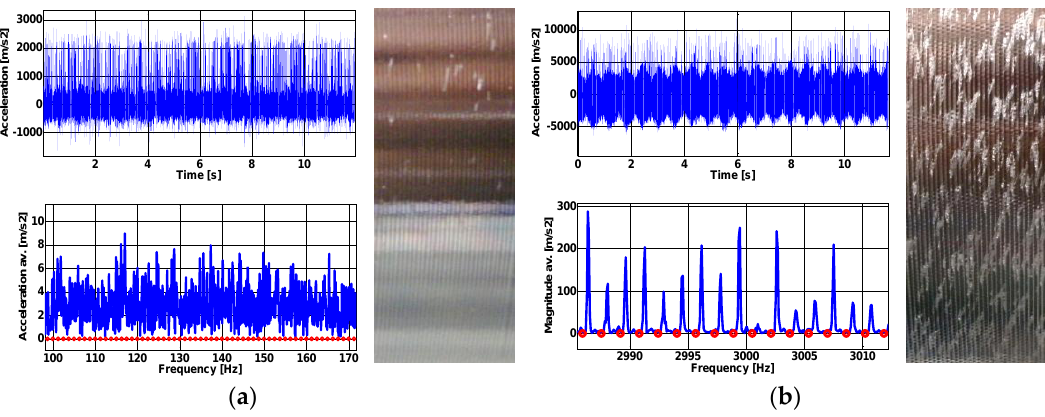
Figure 14. Frequency spectrum of the signal and surface finish: ( a ) Stable case a p = 5 mm/ n = 80 rpm; ( b ) Unstable case: a p = 10 mm/ n = 100 rpm.